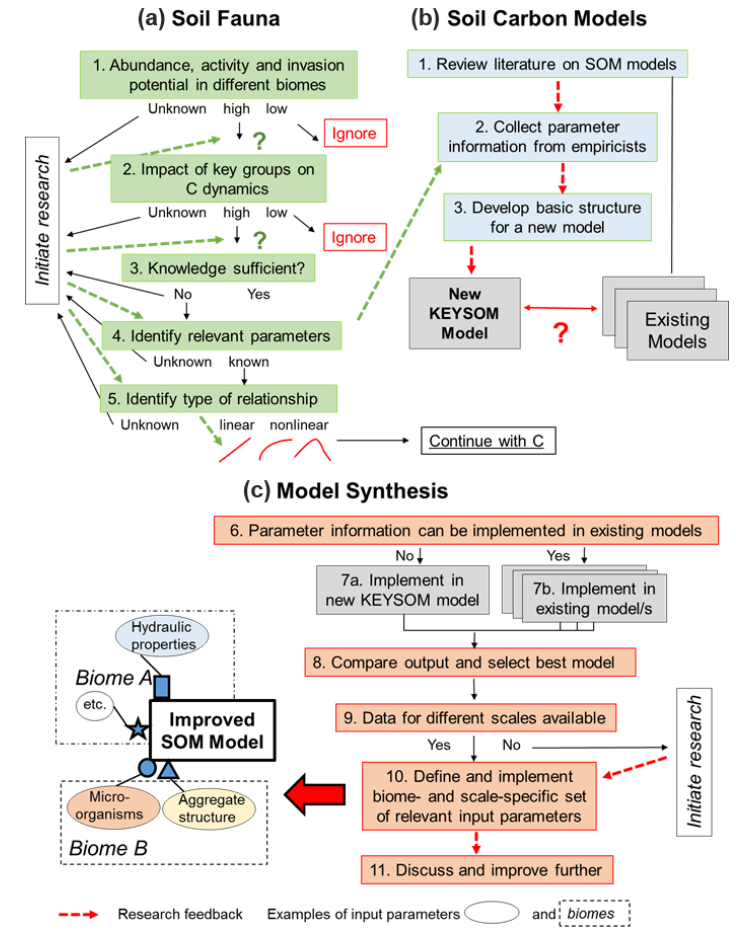
Figure 3. Flow scheme for an improved understanding of the role of soil fauna for soil organic matter (SOM) turnover. This scheme is basically followed within the COST Action ES 1406 (KEYSOM). Activities in (a) and (b) run parallel, followed by (c) , which ends with an improved SOM model. Example scenarios are shown for two biomes. For further explanations, see